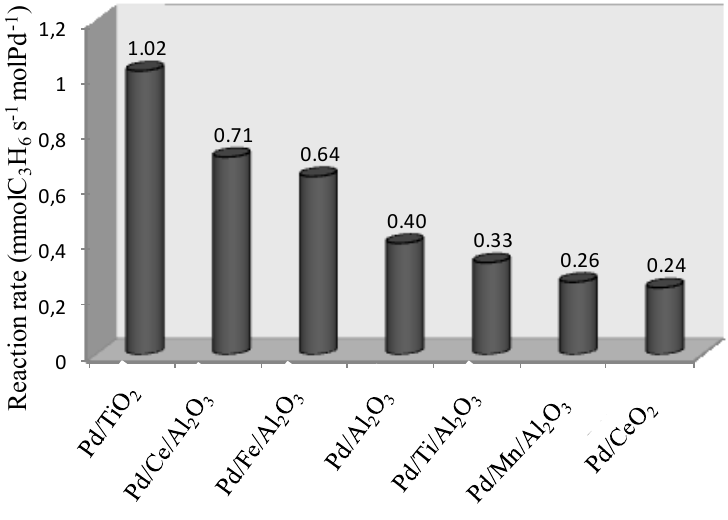
Figure 10. Catalytic activity of Pd-supported catalysts as specific reaction rates calculated at 135